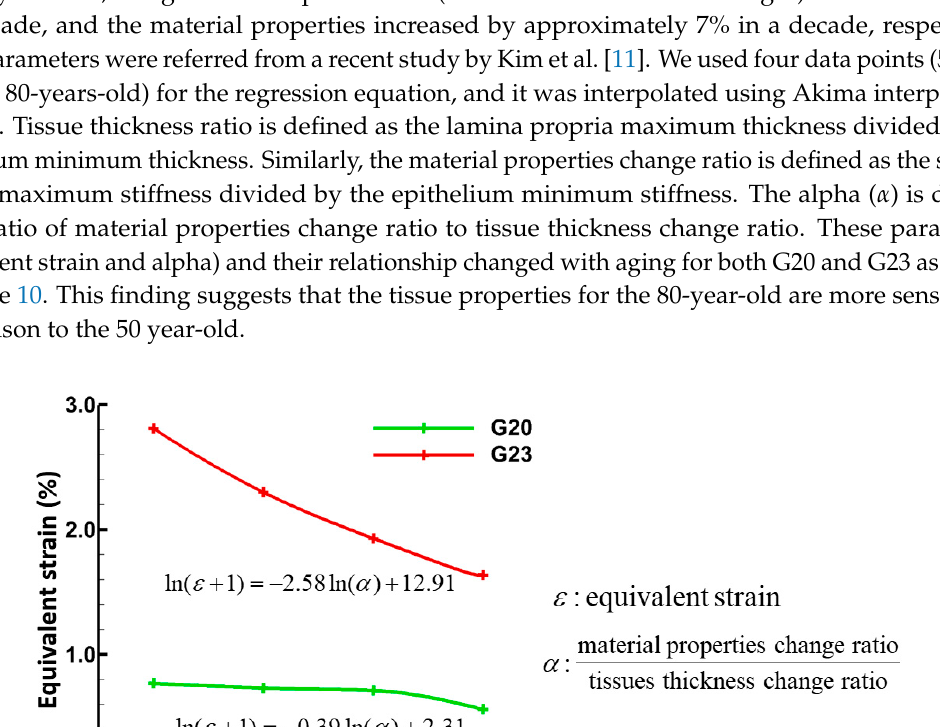
Figure 9. Relationship between normal strain and normal stress during mid ‐ point of exhalation (t = 1.2 s) at ( a ) the bronchiole (G20) and ( b ) the alveolar sac (G23) tissue for the 50 ‐ year ‐ old and the 80 ‐ year ‐ old.